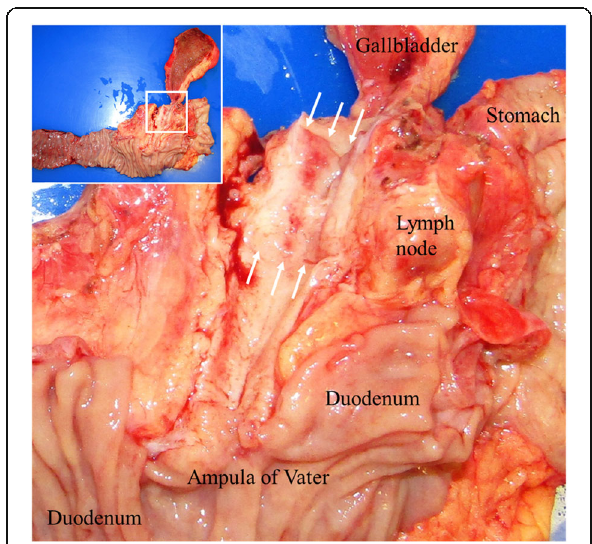
Fig. 4 Macroscopic findings of the resected specimen showed a circumferentially flat, infiltrating lesion in the middle portion of the common bile duct around the junction of the cystic duct (arrow), measuring 25 × 23 × 10 mm in